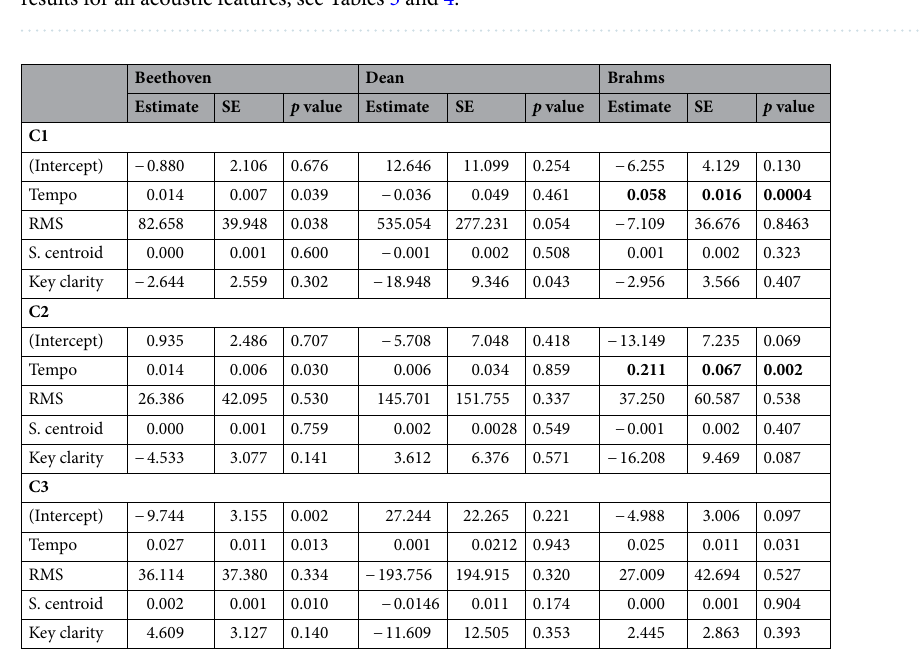
Figure 2. Logistic regression models with all music features (RMS, tempo, spectral centroid and key clarity) predicting high (1) versus low (0) synchrony across listeners, with probability curve of predictor tempo. Columns indicate physiological measures of interest. Rows indicate each piece performed in each of the three concerts (indicated by line style). Here, we highlight the ability of tempo to predict synchrony. For full model results for all acoustic features, see Tables 3 and 4.